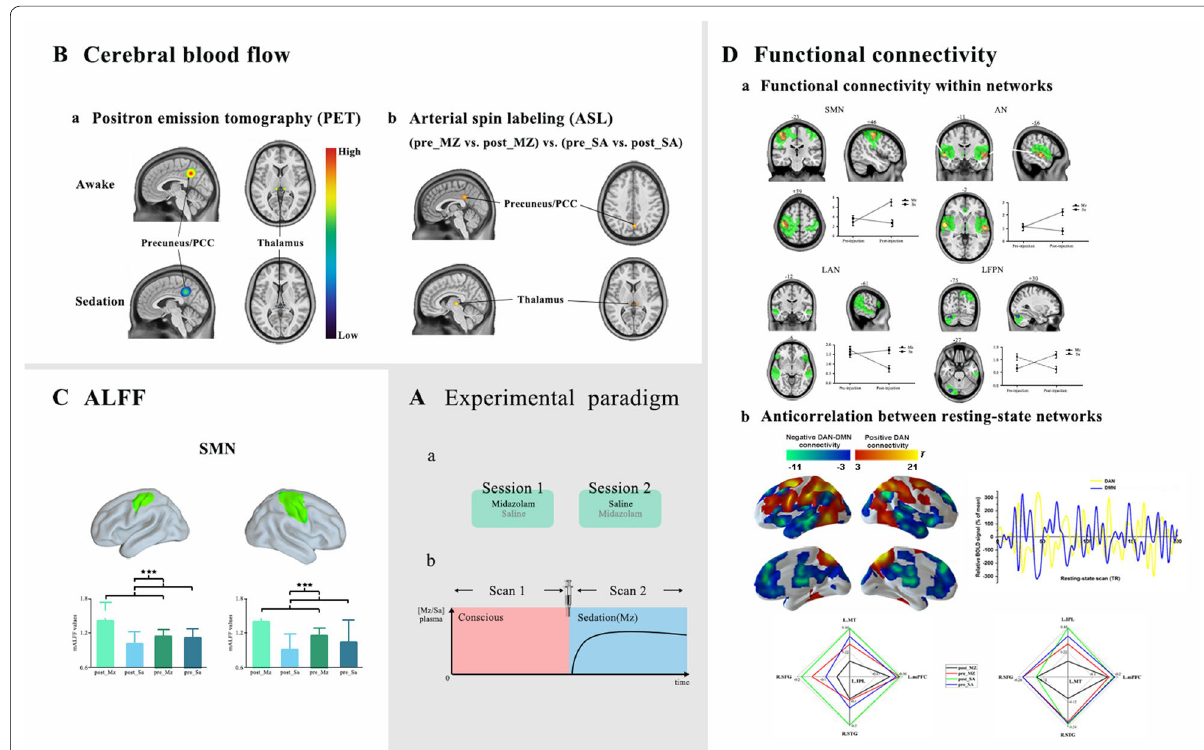
Fig. 2 The typical neuroimaging findings associated with midazolam-induced sedation. A The experimental paradigm of functional studies with midazolam. (a) Volunteers received midazolam in one session and saline in the other. Two sessions were randomly assigned to either midazolam or saline. (b) Scan 1 represented a pre-injection imaging section and scan 2 represented a post-injection imaging section. B Early ASL and PET studies revealed that midazolam-induced sedation was consistently correlated with a reduction in cerebral blood flow in the thalamus and the posterior cortical areas (precuneus or PCC). C Significantly increased amplitude of low-frequency fluctuations (ALFF) was observed in lower-level resting-state networks (e.g., SMN) during midazolam-induced sedation. D Modified resting-state functional connectivity within and between networks during midazolam-induced sedation. (a) Changes of resting-state functional connectivity within networks during midazolam-induced sedation, adapted from Liang et al. [66]; Wiley, USA. Under sedation, decreased cortico-cortical connectivity was found in higher-order brain networks, including the frontoparietal network (FPN) and language network (LAN). In contrast, functional connectivity in low-level networks was intact, including the sensorimotor network (SMN) and auditory network (AN). (b) Altered resting-state functional connectivity between networks. Midazolam significantly decreased the anticorrelation between the dorsal attention network (DAN) and default mode network